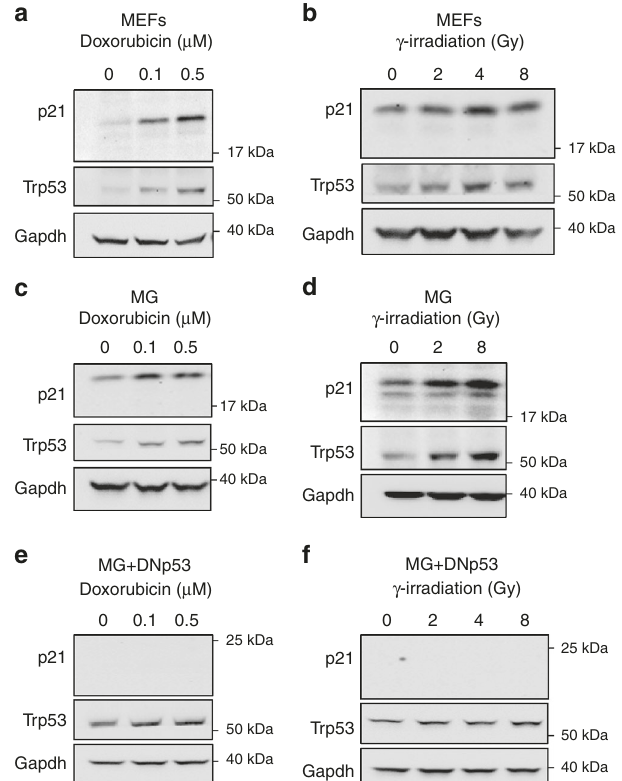
Fig. 5 The p53 pathway remains functional in G fi 1-driven tumors. a , b Western blots for p53 and p21 protein in wild-type mouse embryonic fi broblasts (MEFs) after 4-h treatment with a 0, 0.1, or 0.5 μ M doxorubicin or b 0, 2, 4, or 8 Gy of γ -irradiation. c , d Western blots for p53 and p21 protein in MG tumor cells after 4-h treatment with c doxorubicin or d γ -irradiation. e , f Western blots for p53 and p21 protein in MG tumor